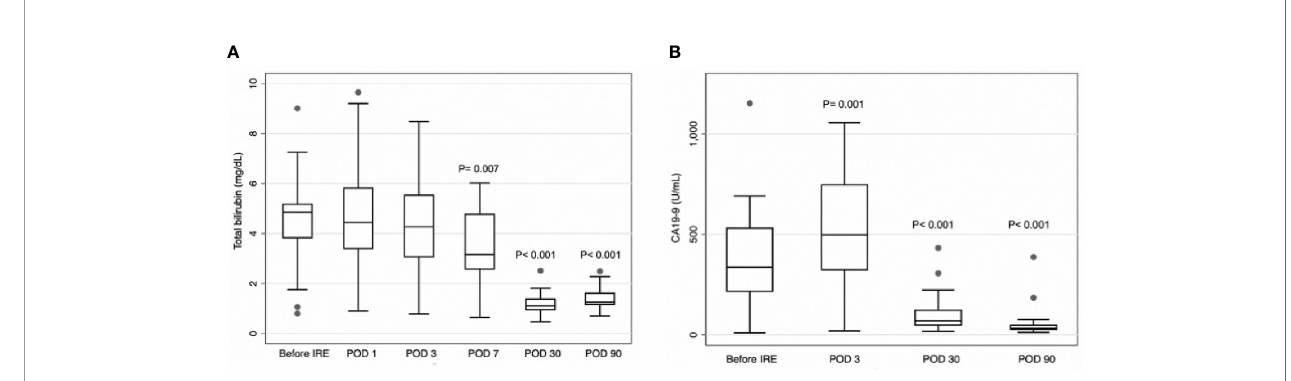
FIGURE 3 | (A) Total serum total bilirubin levels on postoperative day (POD) 7, POD30, and POD90 were signi fi cantly lower than prior to irreversible electroporation treatment (IRE). (B) Serum carbohydrate antigen CA19-9 levels were higher on POD3 and lower on POD30 and POD90, compared to before